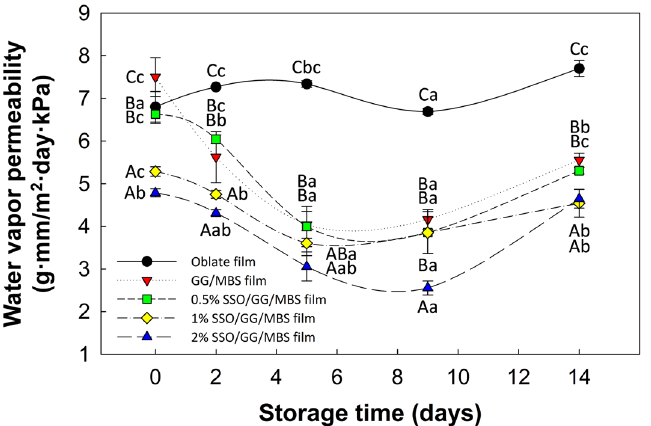
Figure 6. Effect of storage time on water vapor permeability of oblate, GG/MBS, and SSO/GG/MBS films during storage at 25 °C and 50% RH for 14 days. Data are expressed as mean ± standard deviation of three replicates. Different uppercase letters ( A – C ) indicate significant differences ( P ≤ 0.05) among the different groups at the same time points, and different lowercase letters ( a – c ) represent significant differences ( P ≤ 0.05) among time points in the same group by Duncan’s multiple range tests. GG guar gum, MBS mung bean starch, SSO sunflower seed